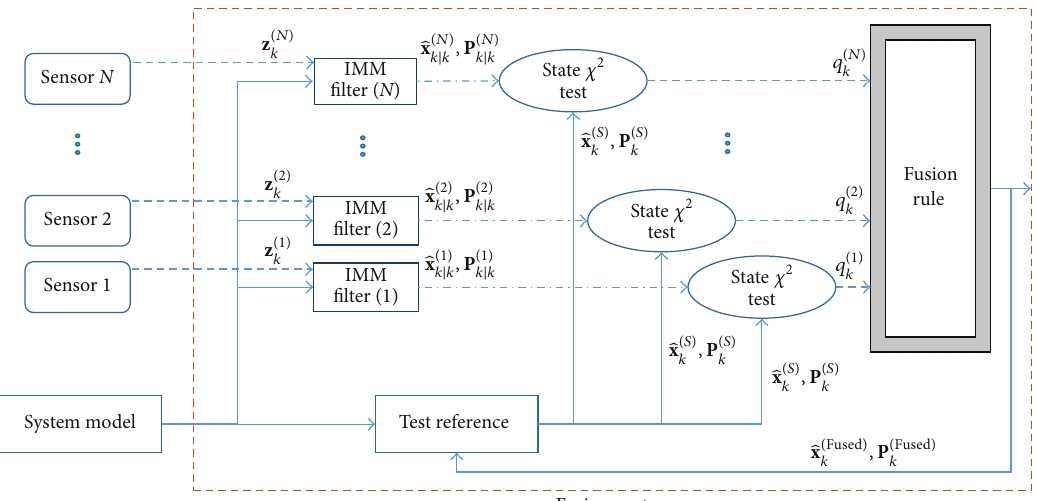
Figure 1: Algorithm